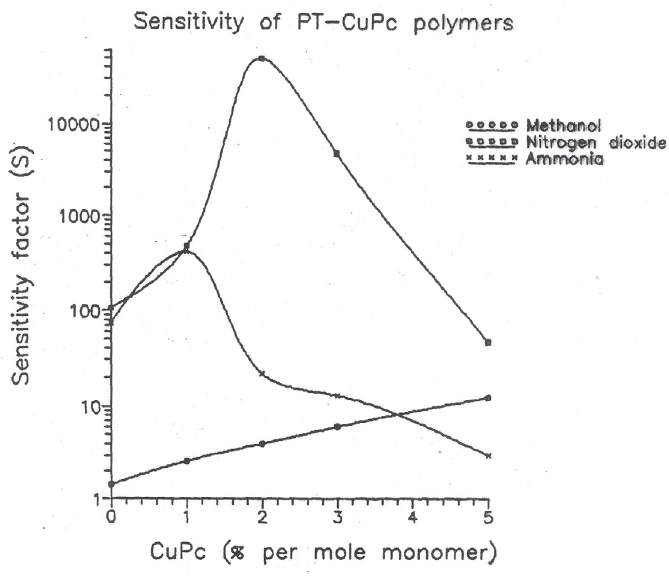
Figure 6. Plots of sensitivity factor versus CuPc concentration for Methanol, ammonia and nitrogen dioxide vapors measured with PT-CuPc/ PEO/ CuCl